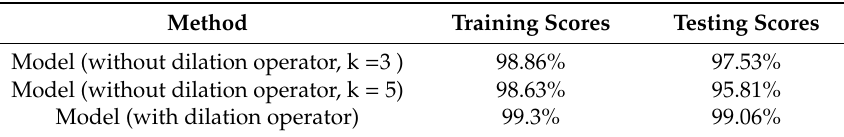
Table 3. Comparison of training and testing performance of the